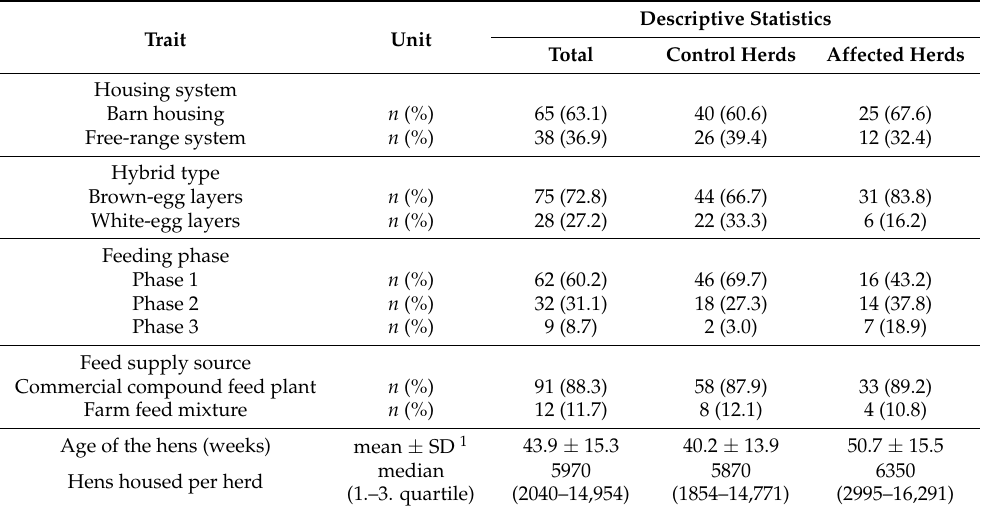
Table 1. Housing system, hybrid type, feed supply source, age of hens, and herd size of the laying hen herds ( n =